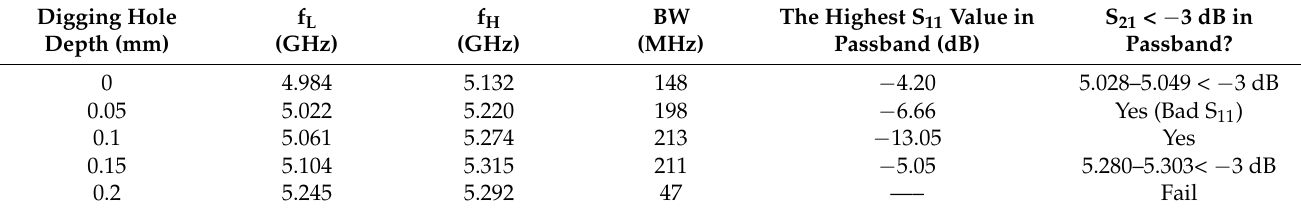
Table A2. The simulation results obtained with a fixed digging radius of 0.5 mm and various digging depths. Digging Hole Depth (mm)